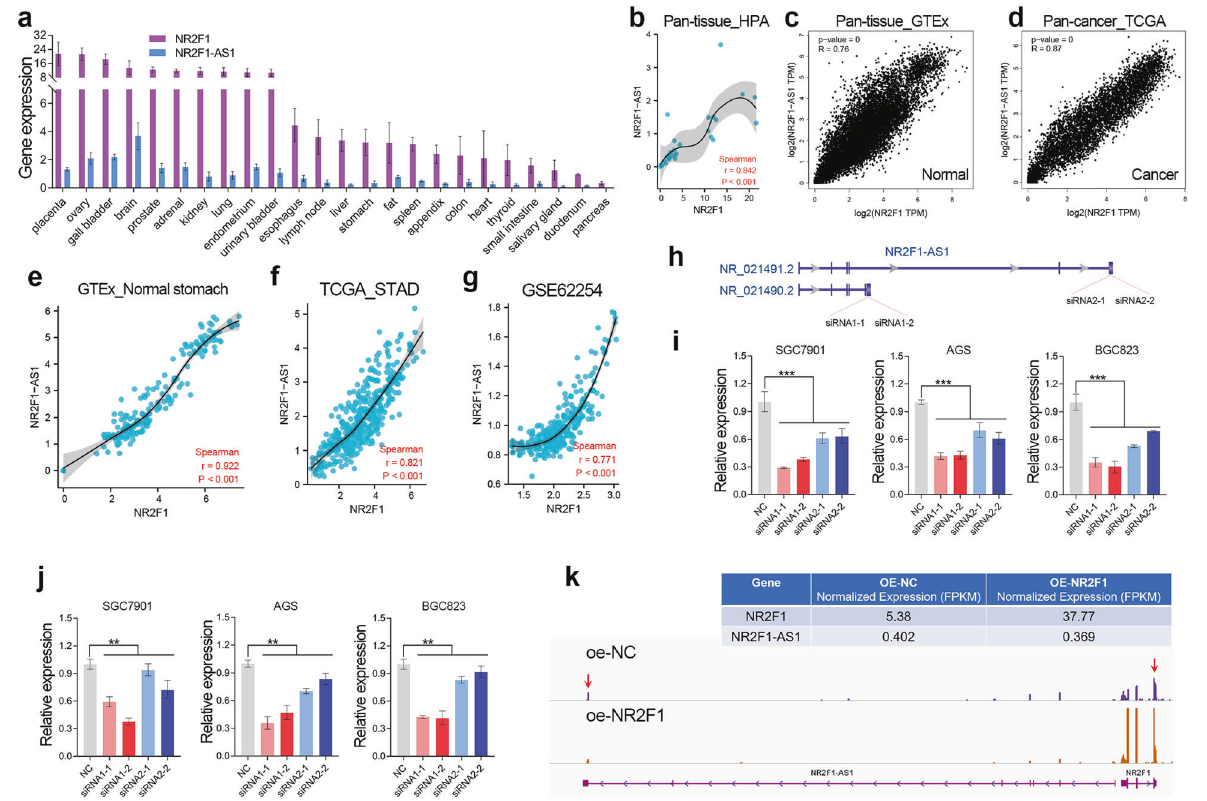
Fig. 4 Depletion of NR2F1-AS remarkably compromised the cellular levels of NR2F1. a The expression of NR2F1 and NR2F1-AS1 in different human tissues obtained from NCBI website. b – d High co-expression of NR2F1 and NR2F1-AS1 was observed in pan-tissue and pan-cancer. e – g NR2F1-AS1 was highly co-expressed with NR2F1 in normal stomach and stomach cancer tissues. h The schematic diagram of the siRNAs targeting NR2F1-AS1. i The ef fi ciency of knockdown of NR2F1-AS1 was determined by qRT-PCR assay. j The expression of NR2F1 was determined after knockdown of NR2F1-AS1 by qRT-PCR assay. k RNA-seq analysis showed that NR2F1 overexpression has no obvious effect on the expression of NR2F1-AS1. ** P <